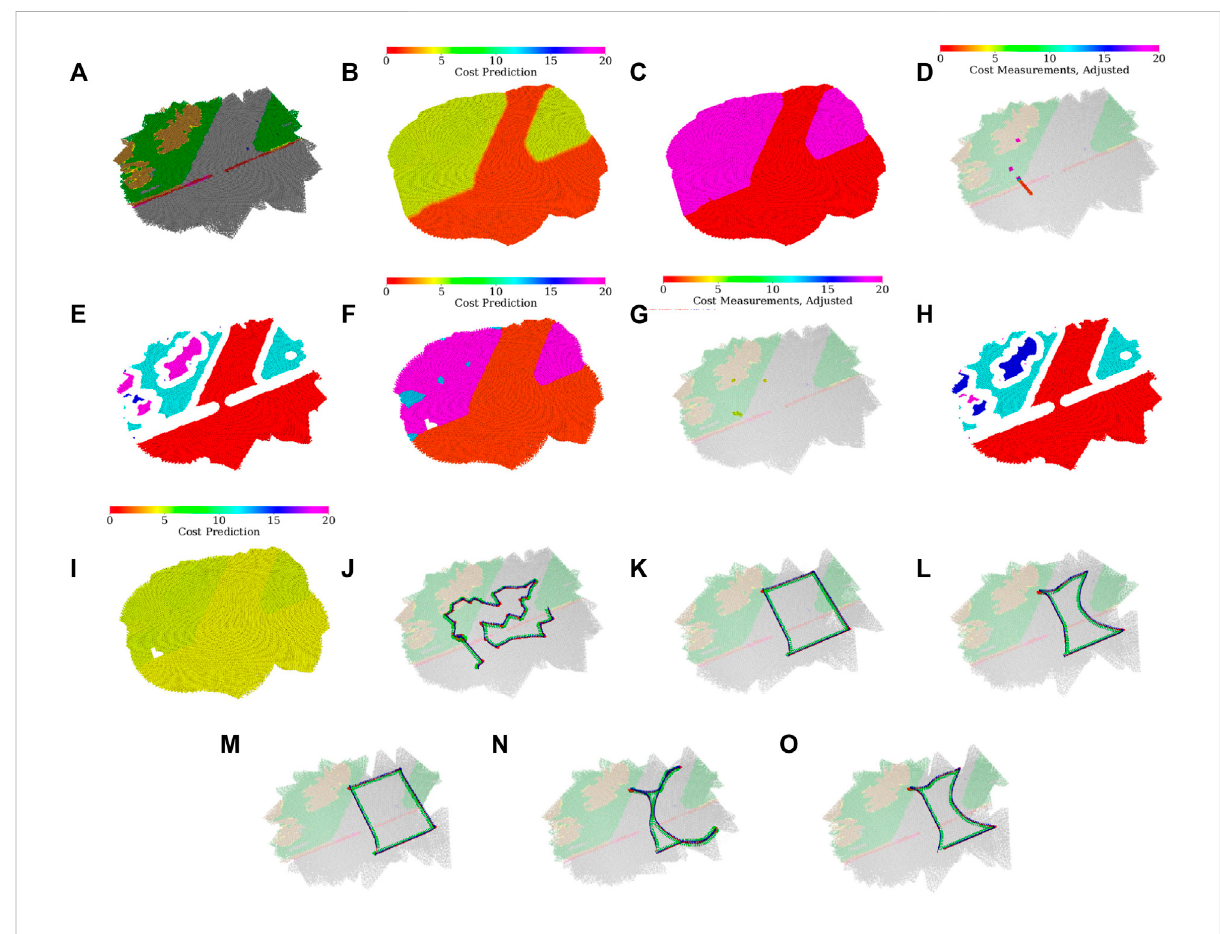
FIGURE 7 Environment assessment after the simulated scenario run with regards to both gaits; (A) dominant color in the histogram feature; (B) merged costusedforplanning; (C) selectedgait(fastinred,tallinpurple); (D) costsusedforlearningthefastgaitmodel[adjustedbyhyperbolictangentin(Eq. 20)], visualized over the terrain appearance; (E) clusters used in the fast gait model (arbitrary colors used to distinguish clusters); (F) fast gait cost predictions assigned by the dilated clusters; (G) costs used for learning the tall gait model [adjusted by hyperbolic tangent using (Eq. 20)], visualizedovertheterrainappearance; (H) clustersusedinthetallgaitmodel(arbitrarycolorsusedtodistinguishclusters); (I) tallgaitcostpredictions assigned by the dilated clusters; (J) exploration run; (K) test-tour run using the baseline model without the learned traversal costs; (L) test-tour run usingthelearnedtraversalcosts.Thedevelopmentofthepaththroughthefullydiscoveredsimulatedenvironmentduringtheexploration; (M) atthe beginningoftheexploration,therobotuses fl atcostsandthusdoesnotavoiddif fi cultterrains; (N) afterlearningthecostsforthefastgait,therobotis too cautious and avoids going near the costly turf; (O) after learning the tall gait costs, the robot is less cautious and is willing to walk near dif fi cult